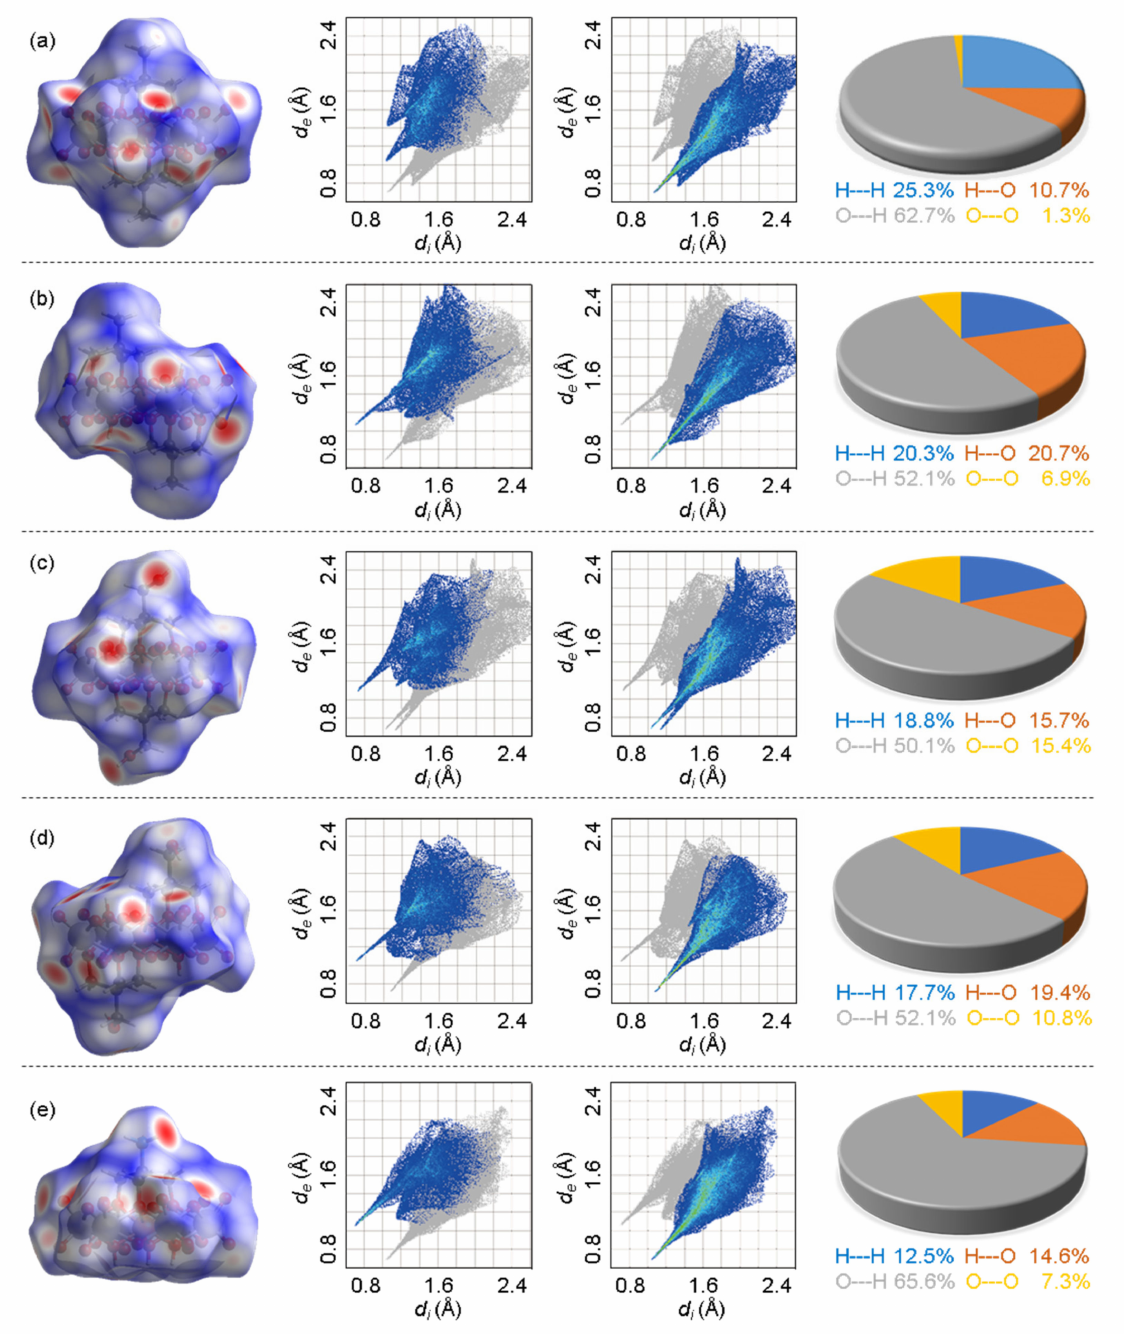
Figure 5. Hirshfeld analysis results for compounds ( a ) 1 , ( b ) 2 , ( c ) 3 , ( d ) 4 , and ( e ) 5 , respectively. For each column, from left to right, the four images are as follows: Hirshfeld surface mapped with d norm in a transparent mode, colored 2D fingerprint plot showing contacts between H (internal to the surface) and H and O (external to the surface), colored 2D fingerprint plot showing contacts between O (internal to the surface) and H and O (external to the surface), and percentage distribution of various short contacts (the detailed percentages of contacts are labeled with the corresponding